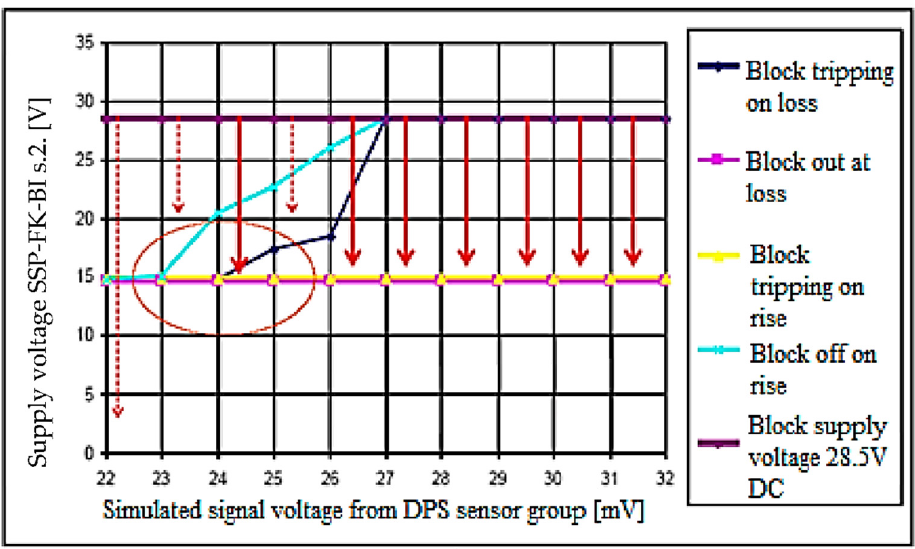
Figure 12. Theoretical response and holding characteristics of SSP − FK − BI block.